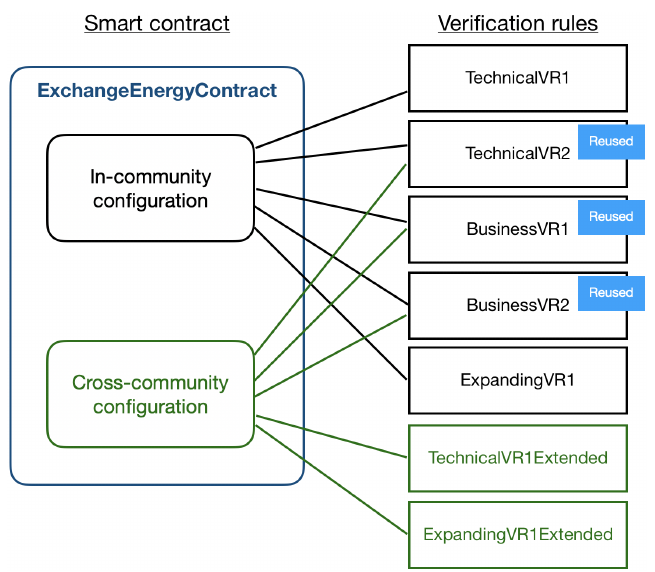
Figure 2. Configurations of verification rules for the